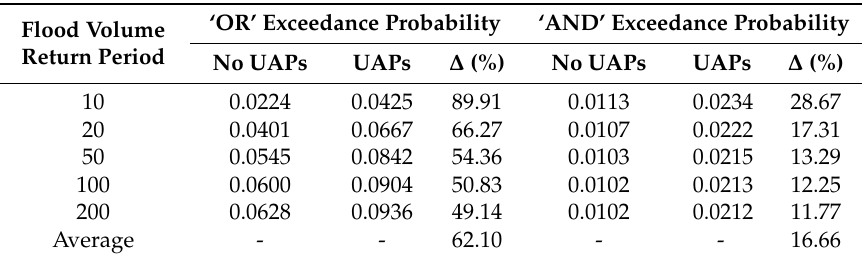
Table 5. The conditional probability of peak flow and water level at different return periods of flood